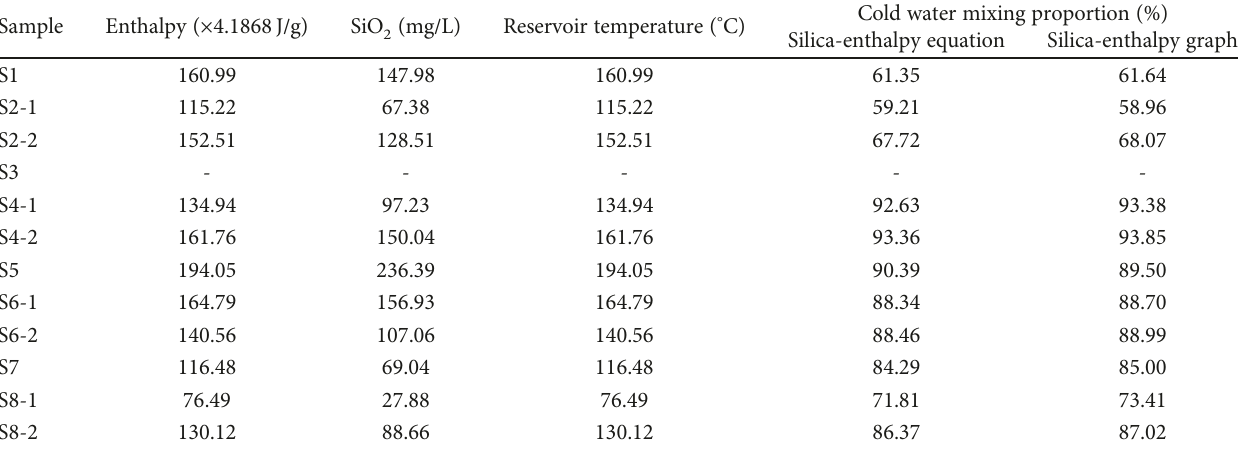
Table 5: Reservoir temperatures considering the mixing e ff ect and the steam loss and cold water mixing proportion of the hot springs in the Simao Basin.